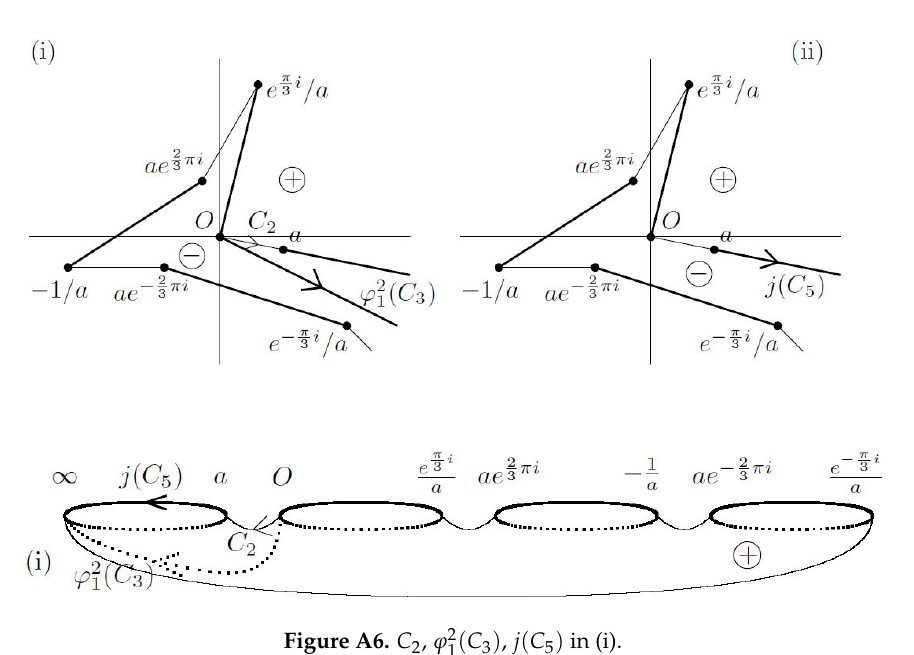
Figure A6. C 2 , ϕ 2